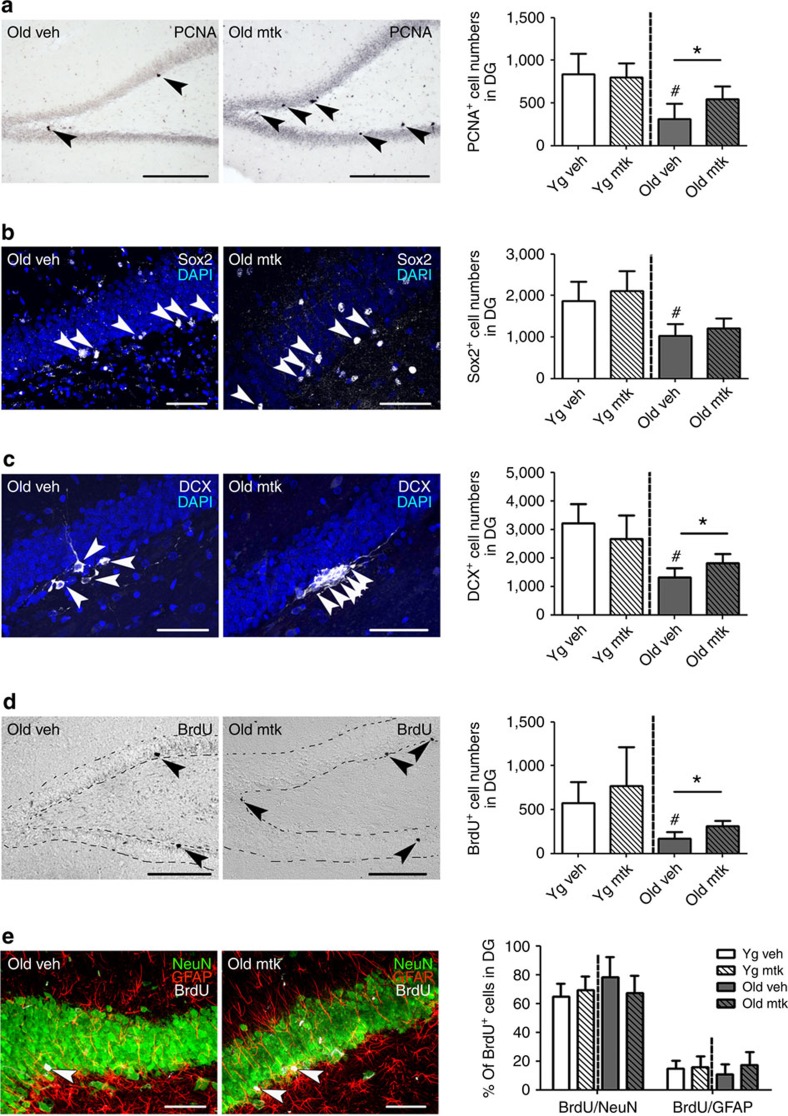
Montelukast treatment increases dentate gyrus neurogenesis in old rats.(a) Number of PCNA+ cell numbers in the DG. (b) Number of Sox2+ neural stem cells in the subgranular zone of the DG. (c) DCX+ cell numbers in the DG. (d) Number of BrdU+ cells 4 weeks after BrdU labelling of the cells. (e) The percentages of BrdU+ cells that have differentiated into neurons (BrdU+/NeuN+) or astrocytes (BrdU+/GFAP+). Arrowheads point to cells stained positively for the respective marker. Pictures illustrate representative images of antibody labelling in the DG of old vehicle and old montelukast-treated rats. Scale bars, 200 μm (a, d), 100 μm (b, c, e). Data are shown as mean±s.d. * indicates P<0.05; # indicates significant differences (P<0.05) specifically compared with young vehicle. One-way ANOVA with Bonferroni post hoc tests was performed. N per group: 10 (young vehicle), 10 (young montelukast), 7 (old vehicle), 7 (old montelukast). Every tenth section (400 μm interval) of one brain hemisphere per animal was analysed. yg veh, young vehicle; yg mtk, young montelukast; old veh, old vehicle; old mtk, old montelukast; DG dentate gyrus.